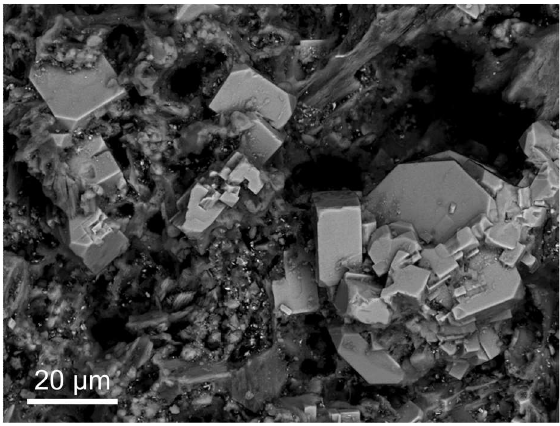
Figure 3. Sharyginite crystals formed by pinacoids {100}, {010}, and {001}, and rhombic pyramid and flattened on (010) at the part of the strongly altered rock. BSE image.